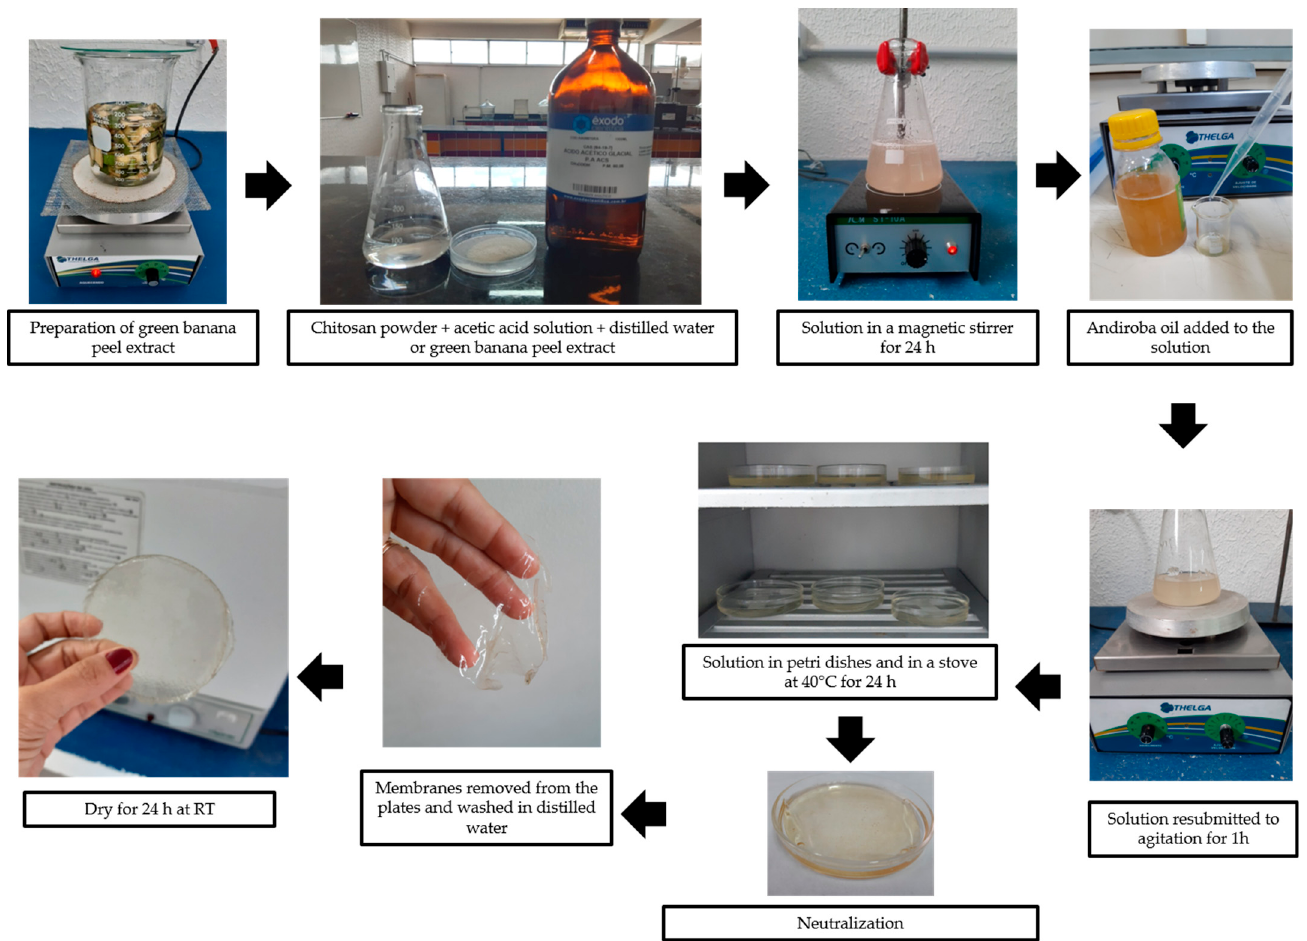
Figure 1. Schematic diagram of the synthesis of membranes by the casting method. Table 2. Description of the acronyms and composition of the synthesized